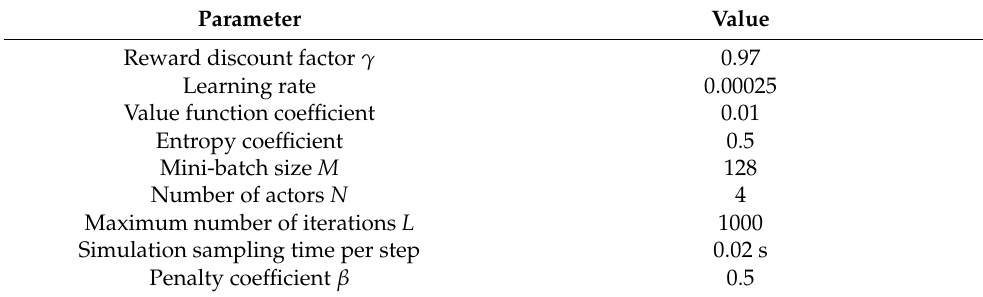
Table 2. Training Table 2. Training parameters.